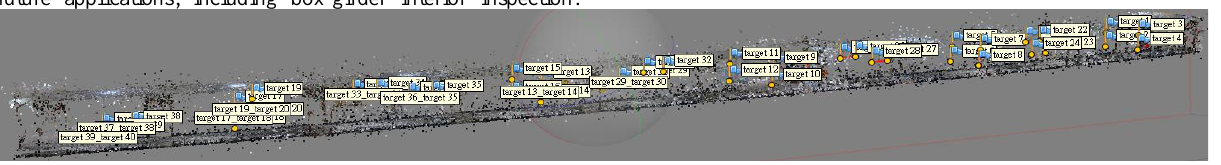
Figure 4. Scale bars distributions (target 1-20 vertical orientations & 21-40 horizontal